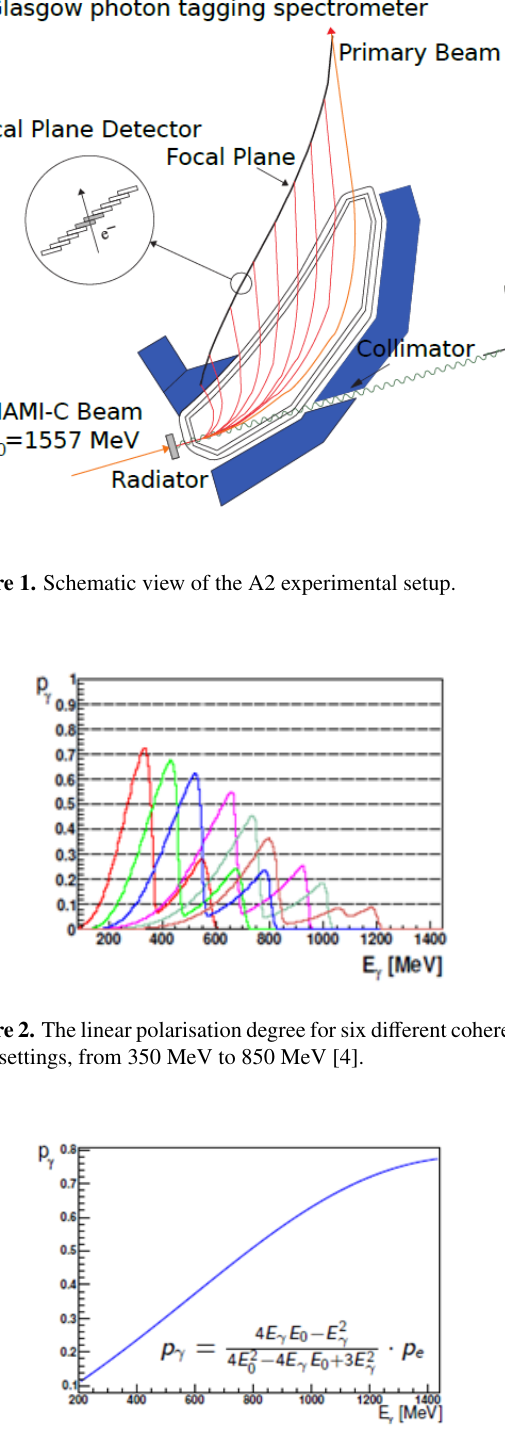
Figure 3. The calculated circular polarisation degree as a func- tion of the photon beam energy